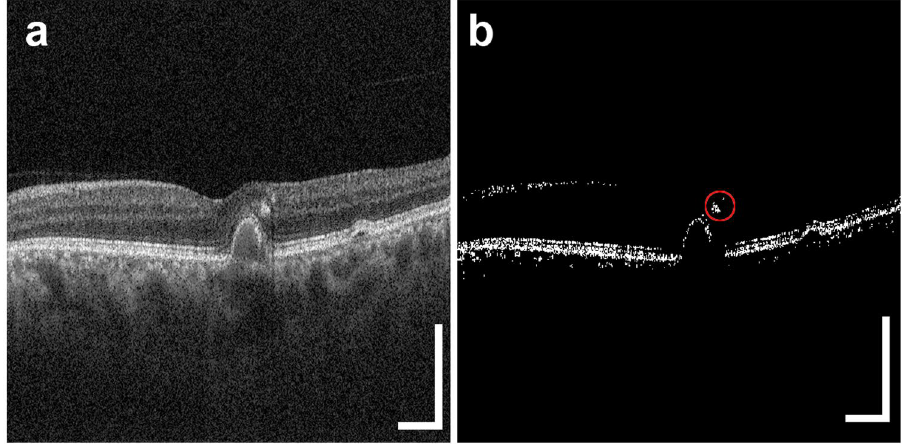
Figure 7. Image processing used to measure the areas of HRF with RPE. Original standard OCT B-scan image ( a ). Image after application of the Shanbhag filter ( b ). The circle with a red line designates the area with HRF. The scale bars represent 500 μ m × 500 μ m. All abbreviations used are as defined in the figure legend for Fig.